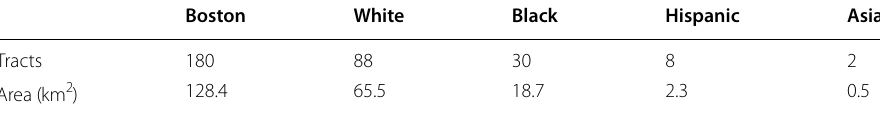
Table 3 Number of tracts and area for Boston and for each group Boston White Black Hispanic Asian Tracts